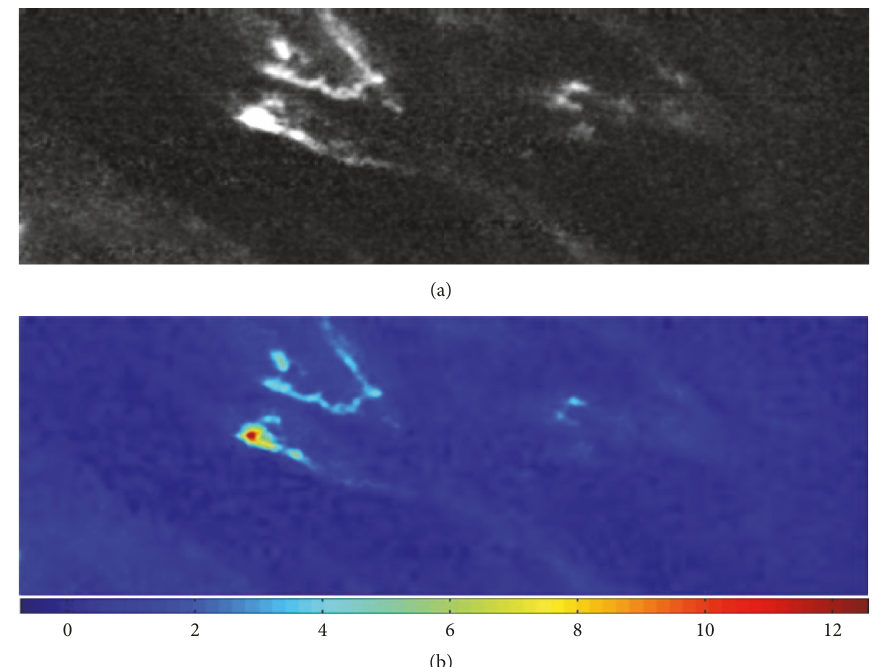
Figure 4: The 715th original image from GALFA-HI. (a) Original image for experiments. (b) Colored image for better visual contrast.